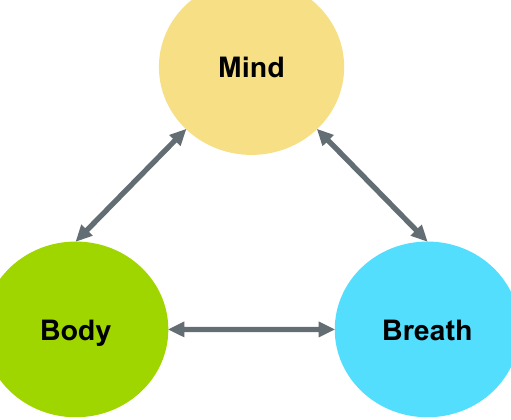
Figure 1. Mind-body-breath feedback loop.